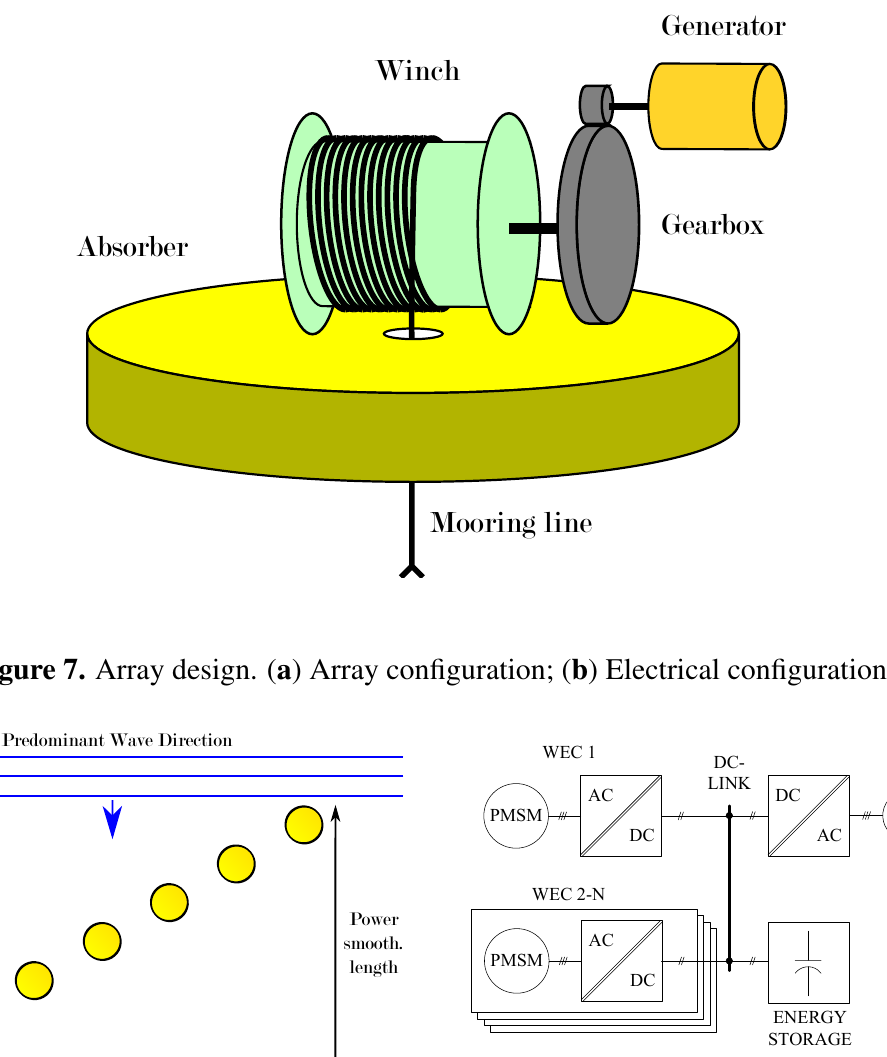
Figure 6. Principal sketch of the WEC.